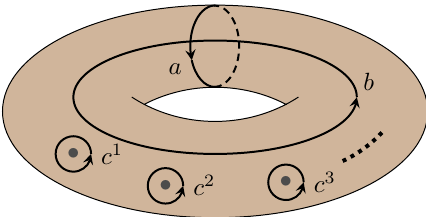
Figure 2 . One-cycles on a punctured torus. The cycle c r goes around the r th puncture. The corresponding four-dimensional theory on S 4 is the one described by an n -node circular b quiver, which we studied in section 3.2. The parameter m r is the mass of the bifundamental hypermultiplet between the r th and ( r + 1) th